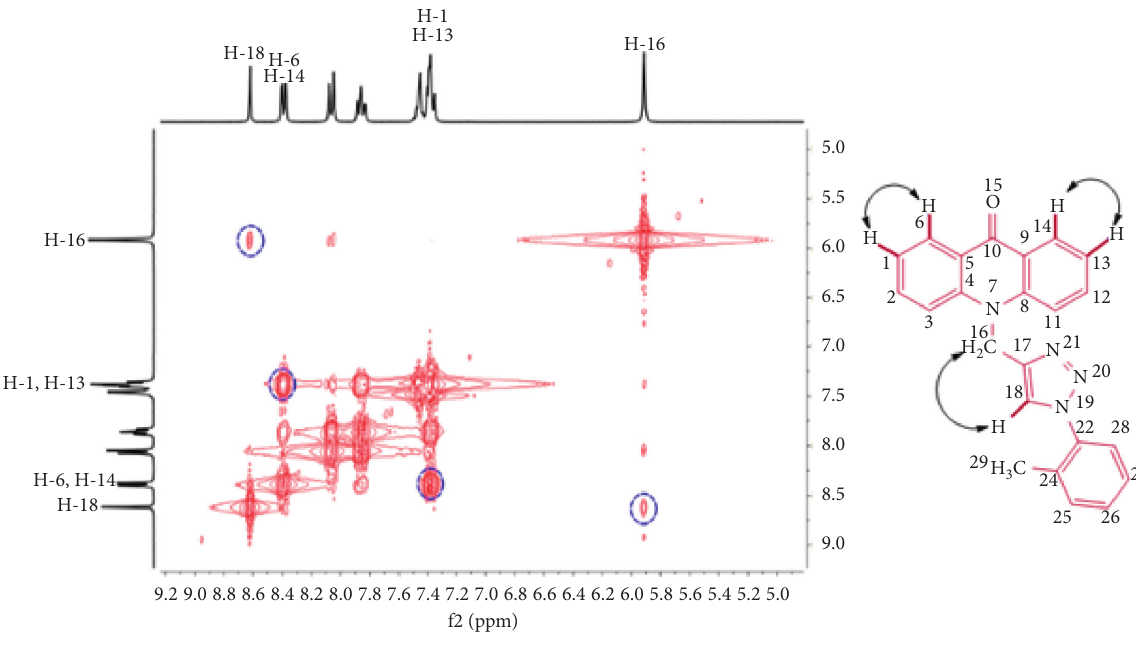
Figure 4: The 1 H- 1 H COSY spectrum of compound